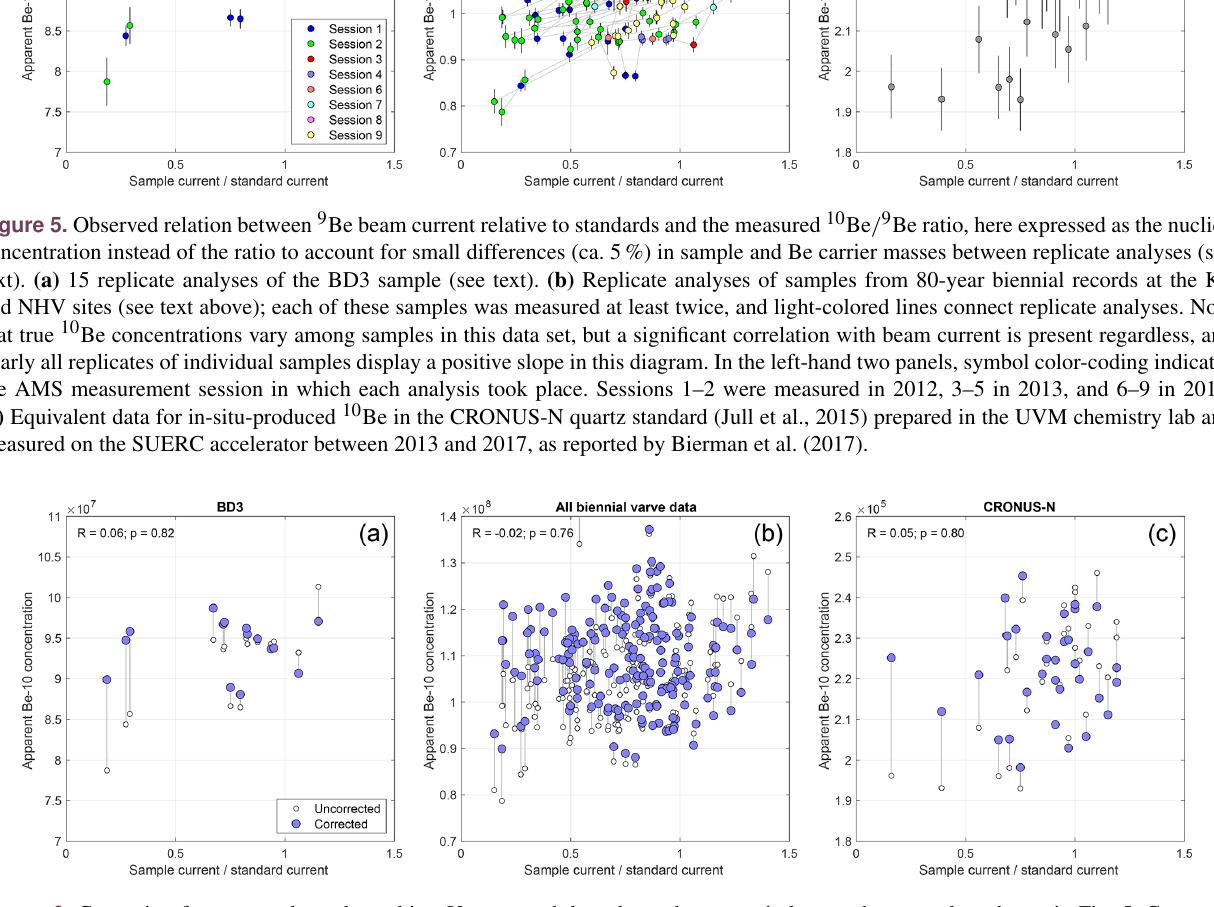
Figure 6. Correction for current dependence bias. Uncorrected data shown by open circles are the same data shown in Fig. 5. Corrected concentrations shown by filled circles are connected by light lines to corresponding uncorrected concentrations; error bars are omitted for clarity. For measurements with beam currents comparable to standards, corrections are minimal and similar in size to estimated measure- ment uncertainties; corrections are most significant for measurements with extreme beam current values. The correlation coefficients and probabilities shown at upper left in all panels are for the corrected